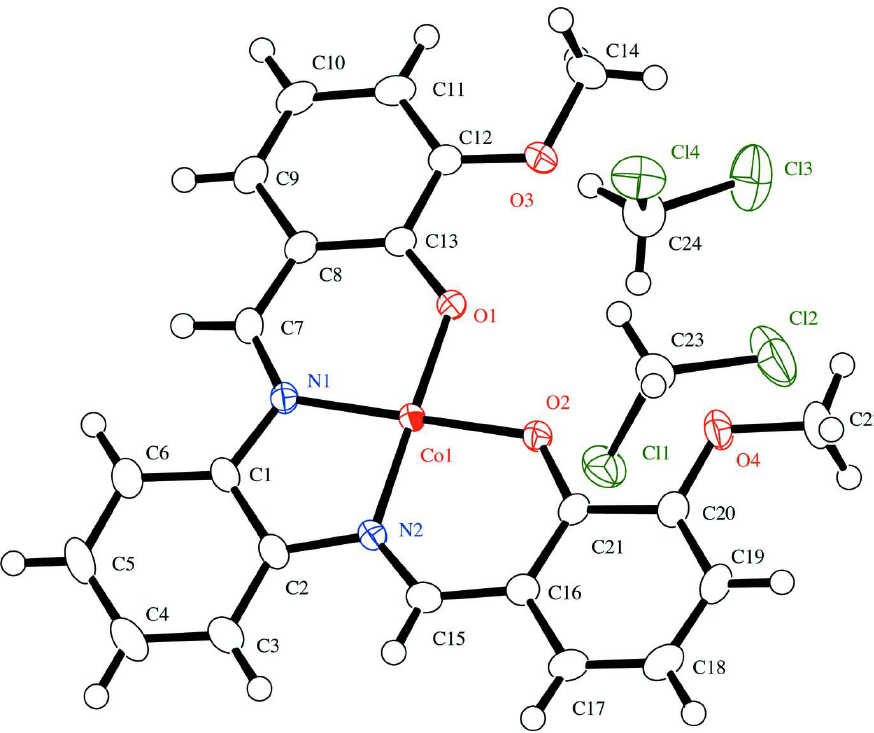
Figure 1 The molecular structure of (I), with the atom-numbering scheme, showing 50% probability displacement ellipsoids. {6,6 ′ -Dimethoxy-2,2 ′ -[ o - phenylenebis(nitrilomethylidyne)]diphenolato}cobalt(II) dichloromethane